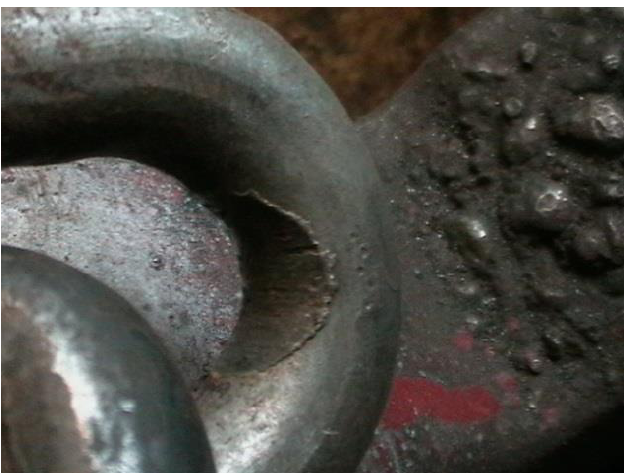
Figure 4. Detail of a worn chain eye.